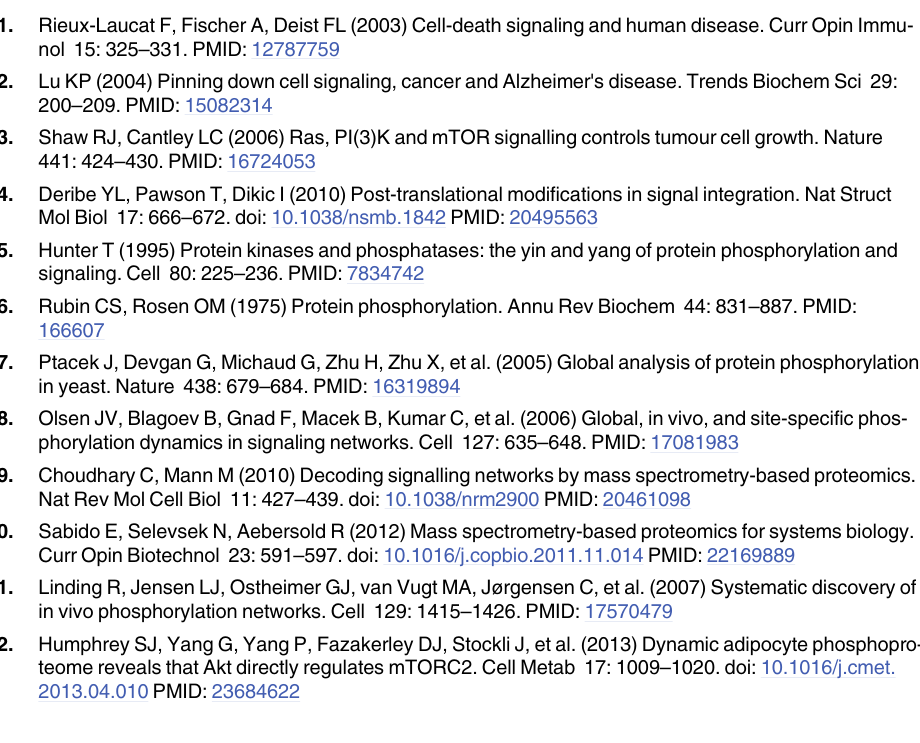
S2 Fig. Simulation results showing CLUE's performance in relation to data noise and num- ber of time points. The yellow line represents the true number of clusters in the simulated dataset, and the red dot denotes the predicted number of clusters in each case. (A) CLUE ’ s per- formance using data from all seven time points (left), data for the last time point simulated as random noise (middle), and data for the last two time points as random noise (right). (B) CLUE ’ s performance using data from all seven time points (left), data from four (1, 3, 5, 7) time points, and data from three (1, 4, 7) time points. S1 Table. Clustering membership scores for hES cell differentiation and insulin activation datasets. S2 Table. Kinases whose substrate are enriched within identified clusters in hES cell differ- entiation and insulin activation